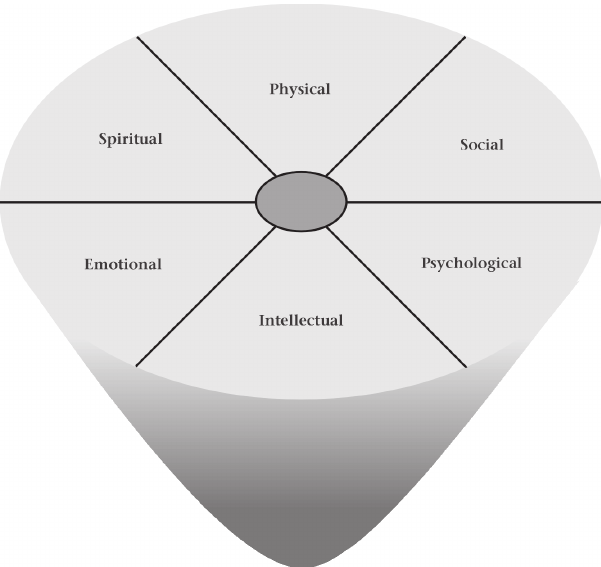
Figure 1: The perceived wellness model (Adams,